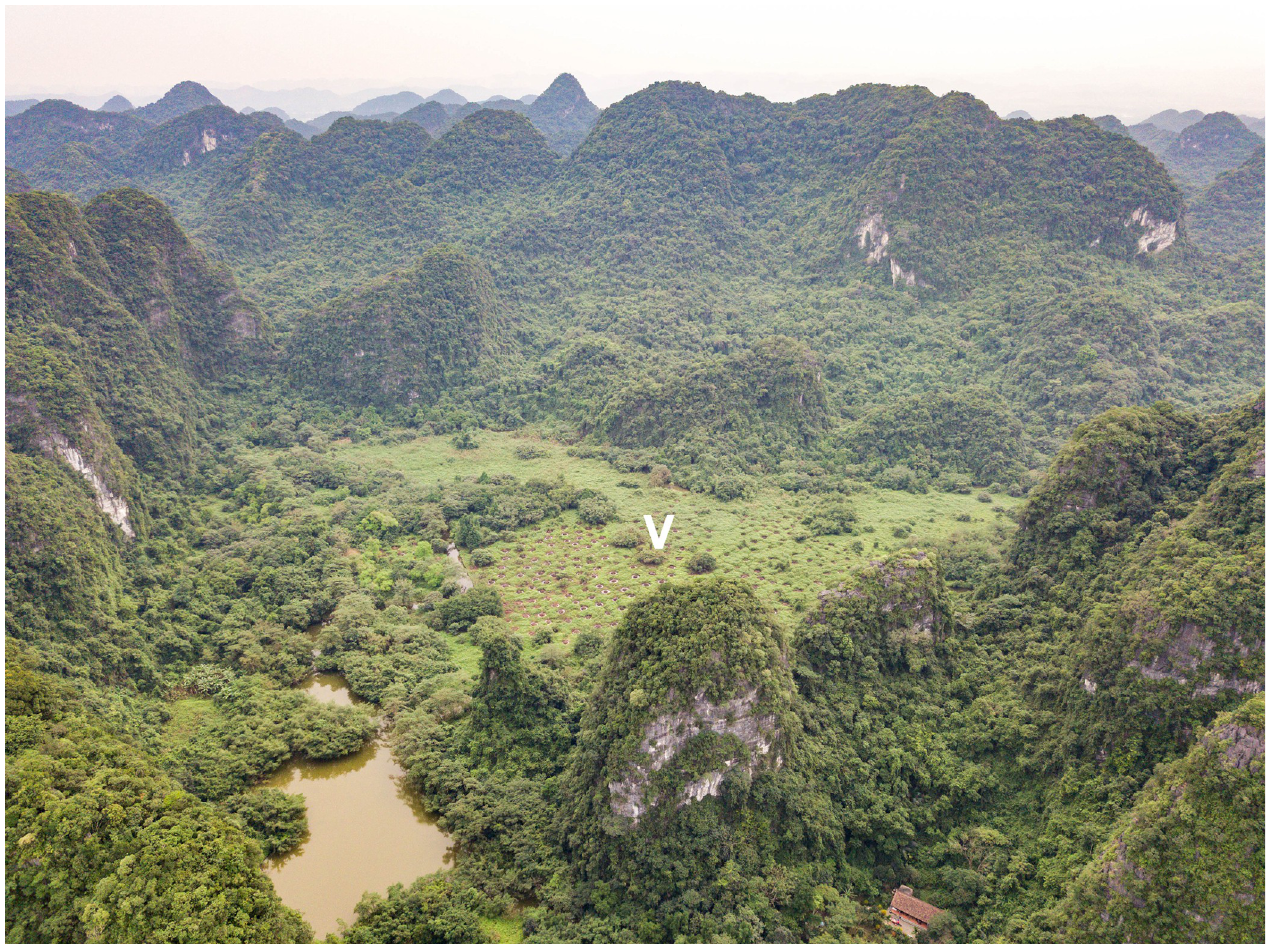
Fig 7. The Vung Tham doline in the centre of the Tr à ng An massif (2017). The white ‘V’ in the centre of the frame denotes the location of the coring site (105.89745˚E, 20.25281˚N) (Photo: Thorsten